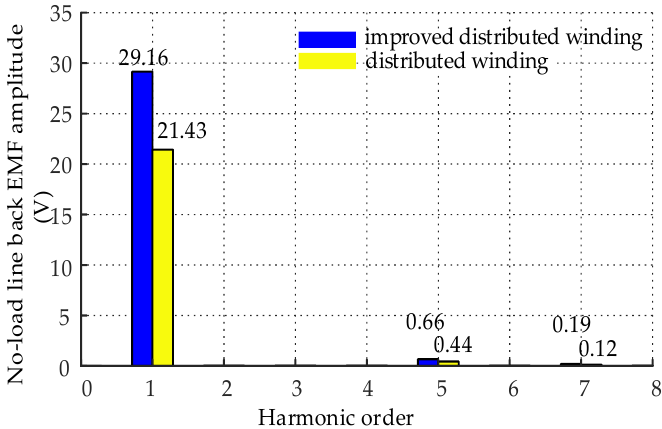
Figure 9. Harmonic decomposition of the no-load line EMF.